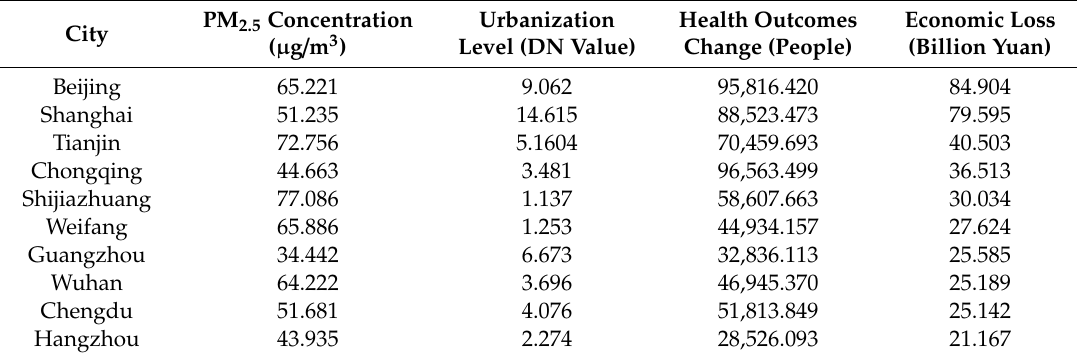
Table 2. The properties of cities with the top ten economic